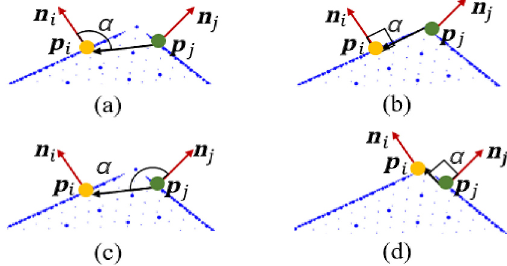
Fig. 3 Movement of the filtered points around sharp edges. Blue points: underlying surface. Yellow, green points: two neighboring points that need to be moved. (a, b) Movement of p j with fixed p i . (c, d) Movement of p i with fixed p j . Note how points move towards the sharp edges and concentrate there, leading to gaps around the sharp edges.